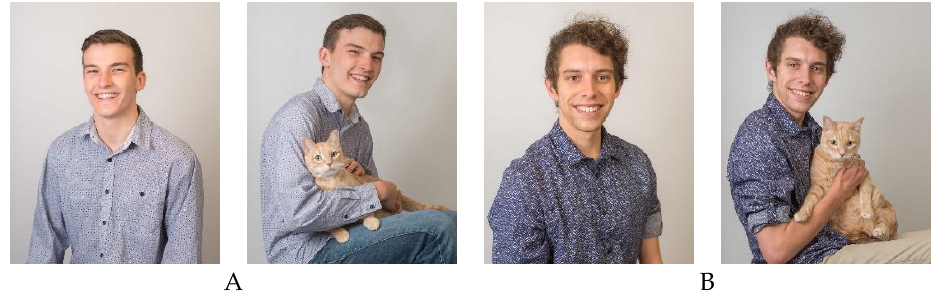
Figure 1. Photos presented to survey respondents. A. Male 1 alone and with cat. B. Male 2 alone and with cat.